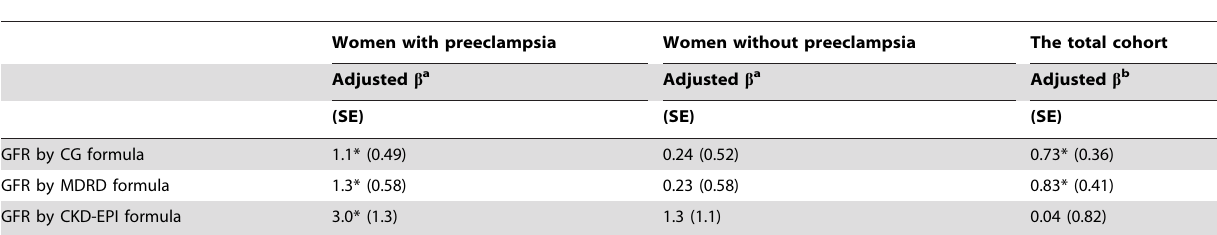
Table 2. Adjusted coefficients with standard errors (SE) from multiple linear regression analysis of the association between infant birth weight and maternal glomerular filtration rate (GFR) in second-trimester estimated by Cockroft-Gault (CG), modification of diet in renal disease (MDRD) and Chronic Kidney Disease Epidemiology Collaboration (CKD-EPI) formulas, based on data from 470 women with preeclampsia, 483 women without preeclampsia and the total cohort of 953 pregnant women from the Norwegian Mother and Child Cohort, Norway